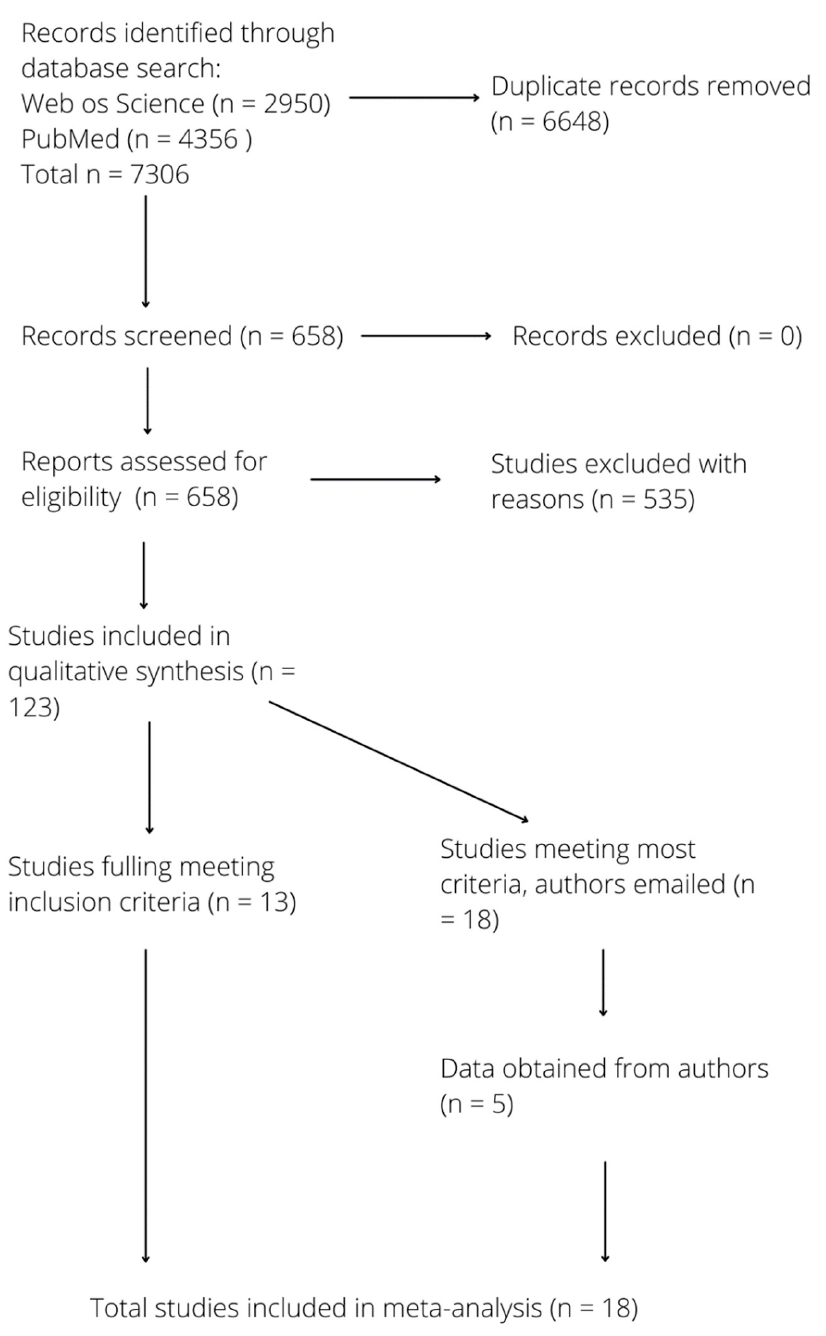
Figure 2. PRISMA flow diagram for systematic review and meta-analysis illustrating the number of records screened, reasons for exclusion, and number of full-text articles included in meta-analysis.